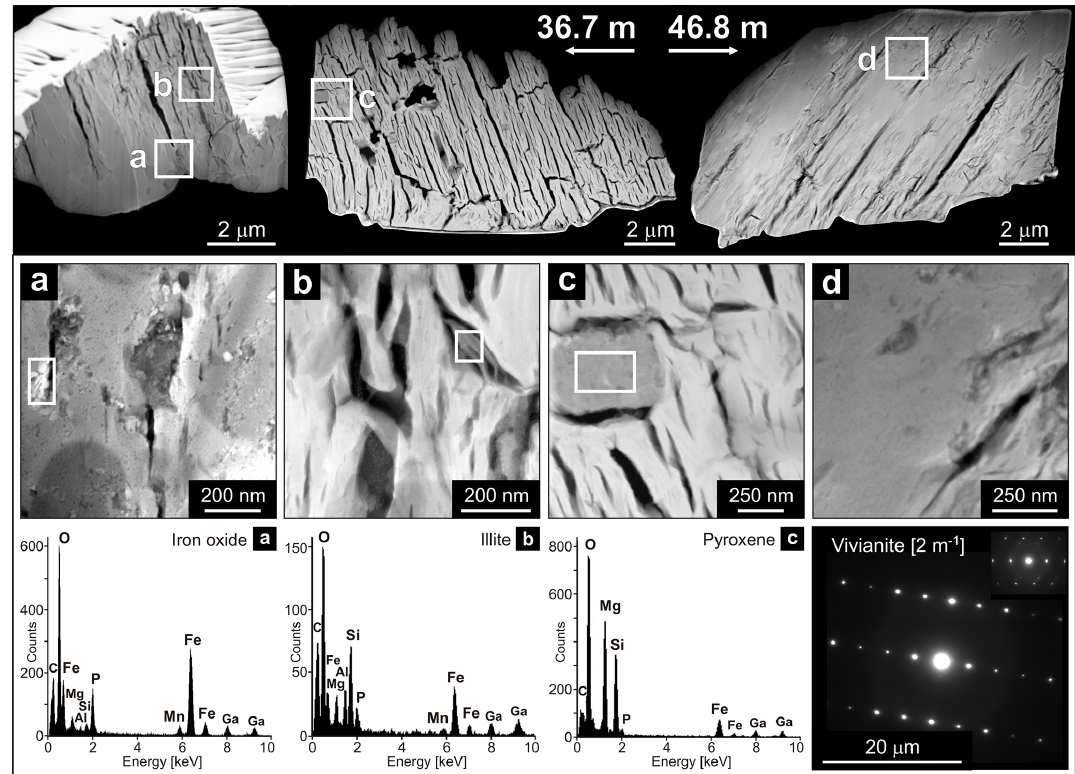
Figure 5. TEM images of vivianite crystal chunks and close-ups of detrital inclusions with their EDX analyses and vivianite electron diffraction patterns. (Top row) TEM images (distance: 330mm) of vivianite crystal chunks from 36.7 and 46.8m depth, showing that the crystal structure is denser in the deeper sample. (Middle row) Close-ups of framed areas illustrating the presence of detrital inclusions within vivianite crystals, namely iron oxide (a) , illite (b) and pyroxene (c) . Panel (d) demonstrates the denser structure of the vivianite crystal from 46.8m depth. (Bottom row) EDX spectra for iron oxide (a) , illite (b) and pyroxene (c) . (Bottom right) The high-resolution electron diffraction pattern of the vivianites from 46.8 and 36.7m depth, providing evidence for an organized and less-organized monoclinic